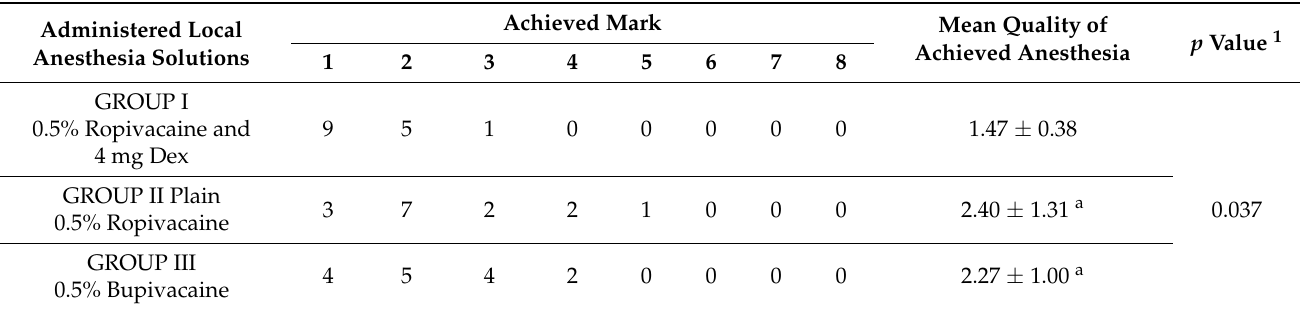
Table 3. Achieved quality of anesthesia scores